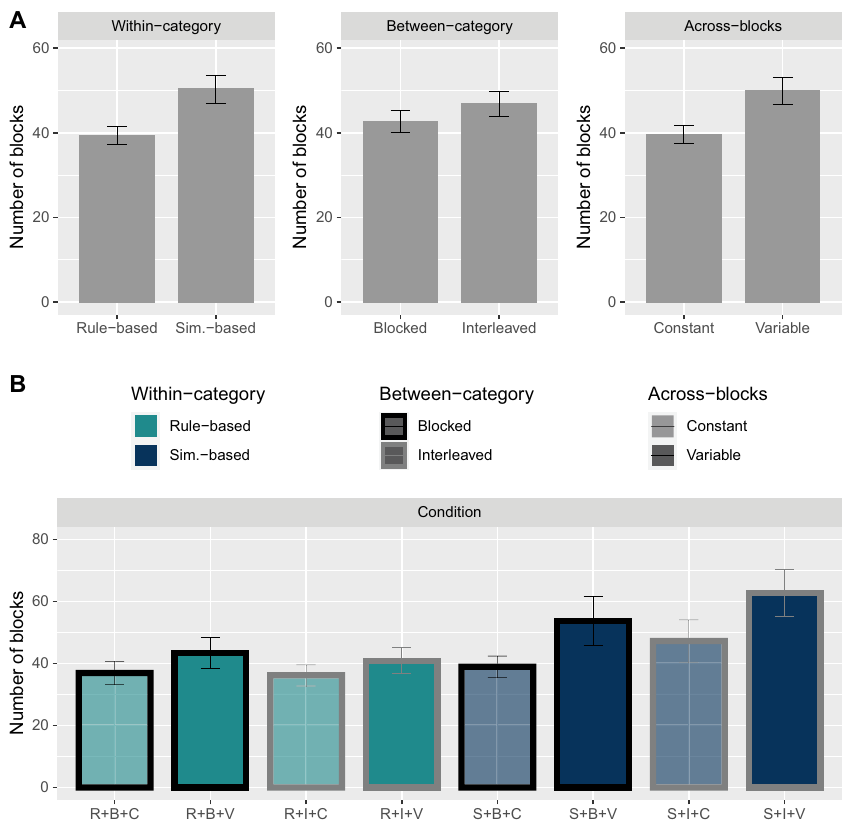
Figure 2. Average number of blocks taken by participants to meet the learning criterion as a function of the experimental conditions, taken separately ( A ) and combined ( B ). In ( B ), color distinguishes the within-category order (light blue for rule-based and dark blue for similarity-based), contrast of borders distinguishes the between-category order (black for blocked and gray for interleaved), and opacity of the colors distinguishes the across-blocks order (semi-transparent for constant and opaque for variable). Error bars show ± 1 SE . Note that only the participants that reached the learning criterion are plotted in this